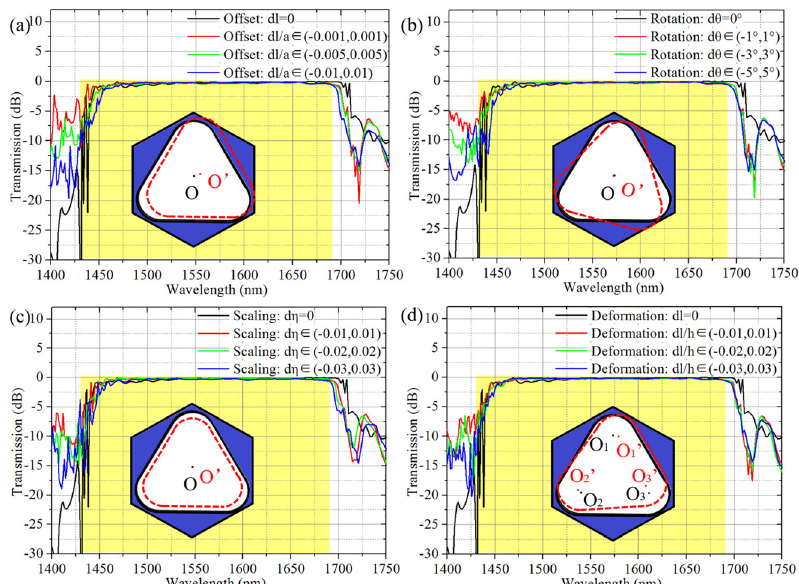
Figure 5: Bandwidth of the VPC with the defective triangular air holes. (a) Offset of triangular hole center with d l = L OO ′ ; (b) rotation of triangular hole with d θ ; (c) Scaling of integral triangular hole with d η ; (d) deformation by offset three corners of ≤ dl , L ≤ dl , triangular hole with L O O 2 O ′ 2 1 O ′ 1 ≤ dl .Theinsetsarethesketchesof and L O 3 O ′ 3 four disorders and the red dashed lines indicate the defective triangular air holes. The yellow shaded indicate the bandwidth of the VPC without defect. All data are the average values of ten stochastic